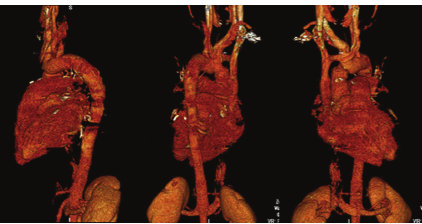
Figure 3: 3D reconstruction of the aorta 82 days after aortic